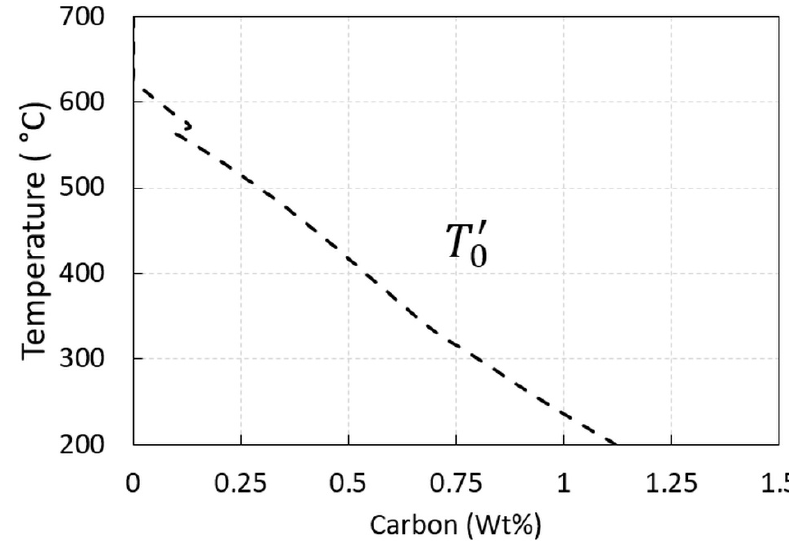
Figure 4. Calculated T (cid:48) using MUCG 83 concerning carbon in austenite [33].